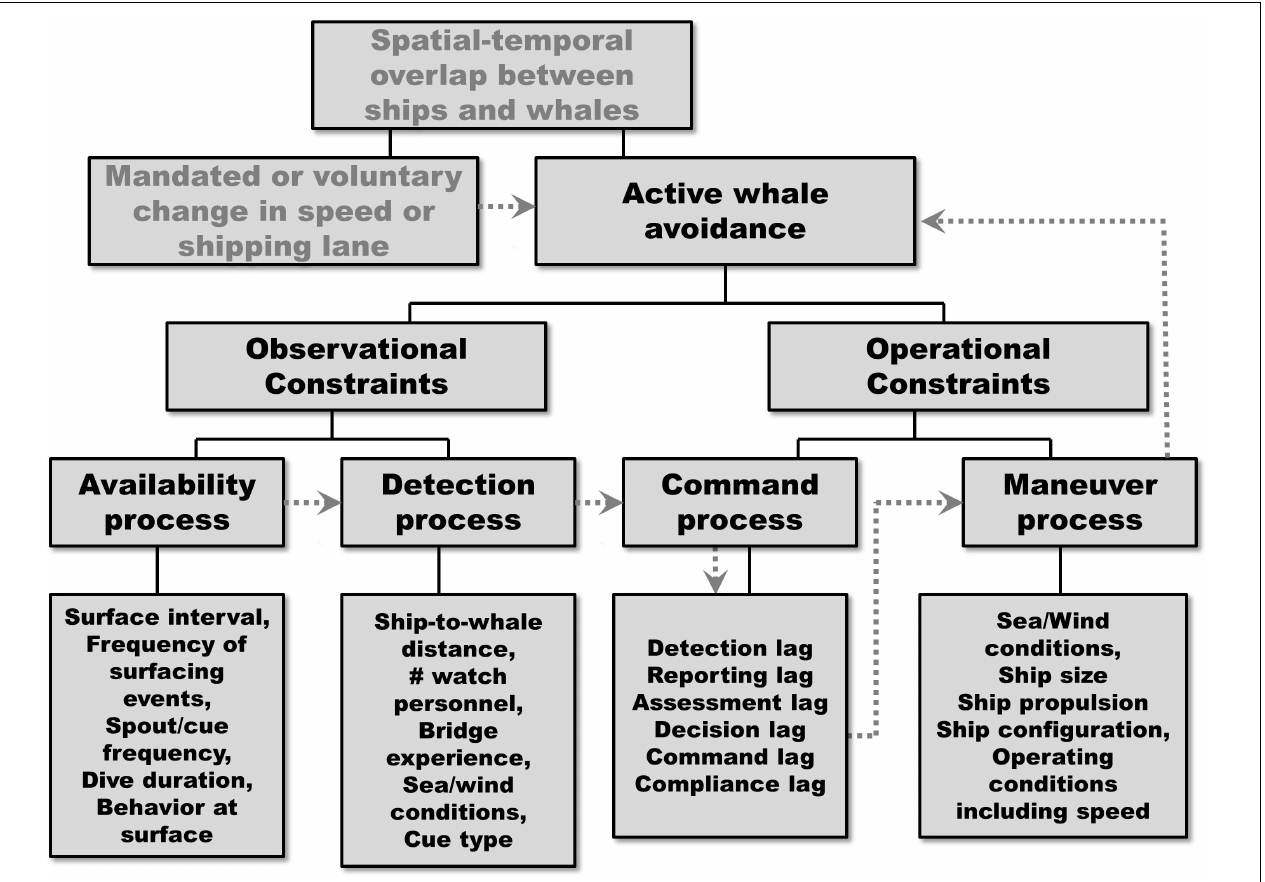
FIGURE 1 | Conceptual model depicting some components related to active whale avoidance by mariners aboard large ships. The first two rows reflect opportunity: active whale avoidance can be practiced anywhere in the world where there is overlap between large ships and large whales, including within management areas that already require (or encourage voluntary) speed reductions or within shipping lanes that have been altered to minimize ship-whale encounters. Lowermost boxes represent a sampling of important factors that may influence their related processes either singly or in concert with other factors. The arrows among the lower boxes reflect the general chronology of whale